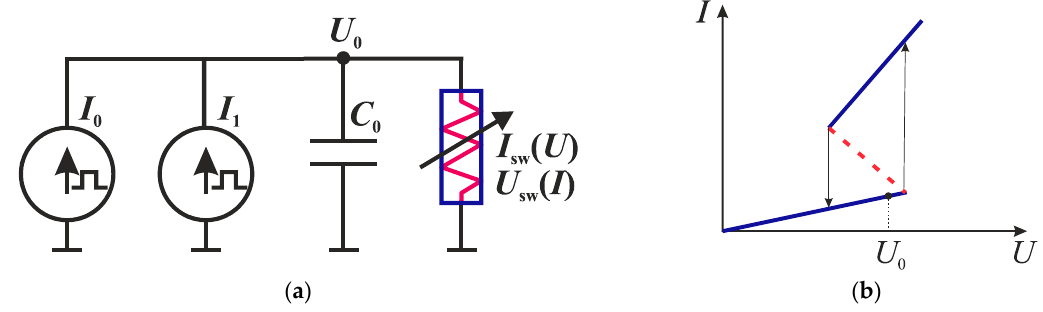
Figure 14. Circuit modeling the integrate-and-fire neuron ( a ) and an example of the operating point of the circuit in sub-threshold mode ( b ).